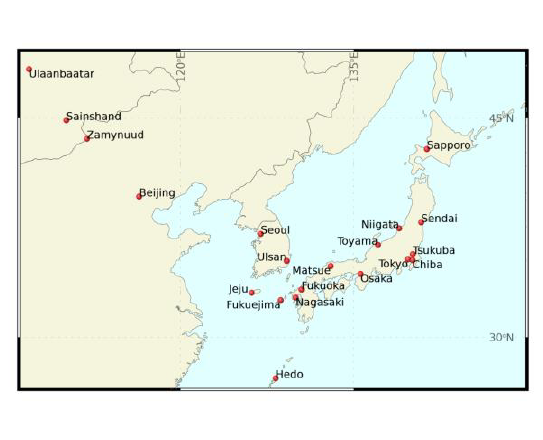
Fig.1 Locations of lidars in